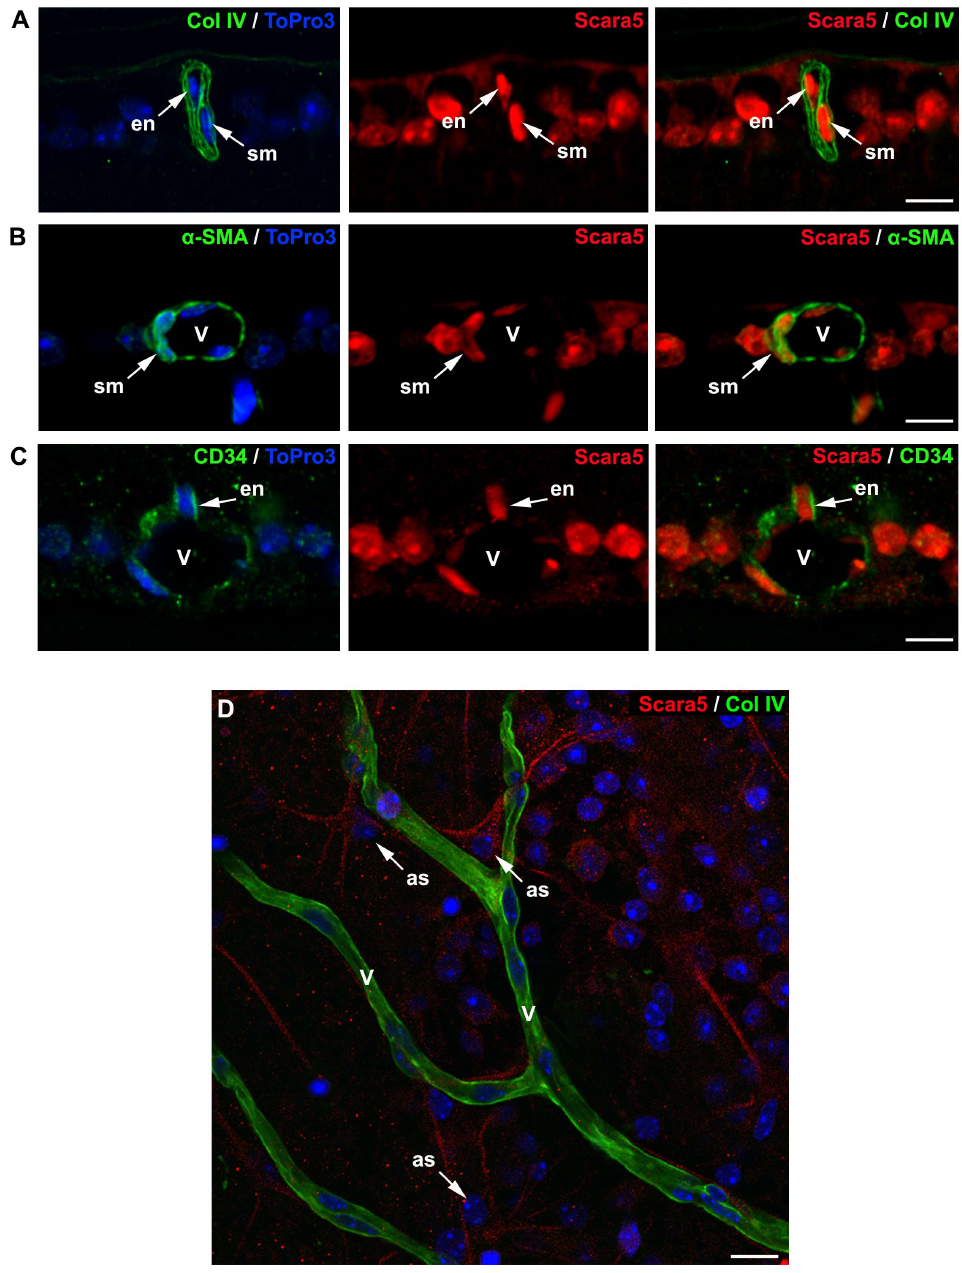
Figure 6. Retinal vasculature expressed Scara5 receptors. A: Cells surrounded by the blood basement membrane marked with collagen IV showed intense Scara5 signal. B and C: Dual immunolabeling with Scara5 and with a -SMA and CD34, respectively, confirmed that vascular smooth muscle cells and endothelial cells expressed Scara5 receptors. D: Whole mount retinas immunohistochemically marked with collagen IV and Scara5 showed that perivascular astrocyte-like cells intensively expressed Scara5 in their vascular end-feet. Nuclei were counterstained with ToPro3. en, endothelial cell; sm, smooth muscle cell; v, blood vessel; as: astrocyte-like cell. Scale bars: 10 m m (A); 9 m m (B); 9 m m (C); 12 m m (D).